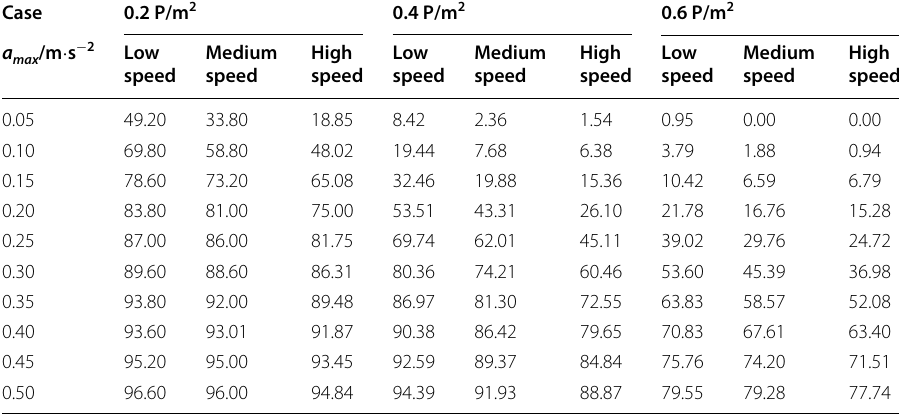
Table 3 Cumulative probability distribution table under various working conditions Case 0.2 P/m 2 0.4 P/m 2